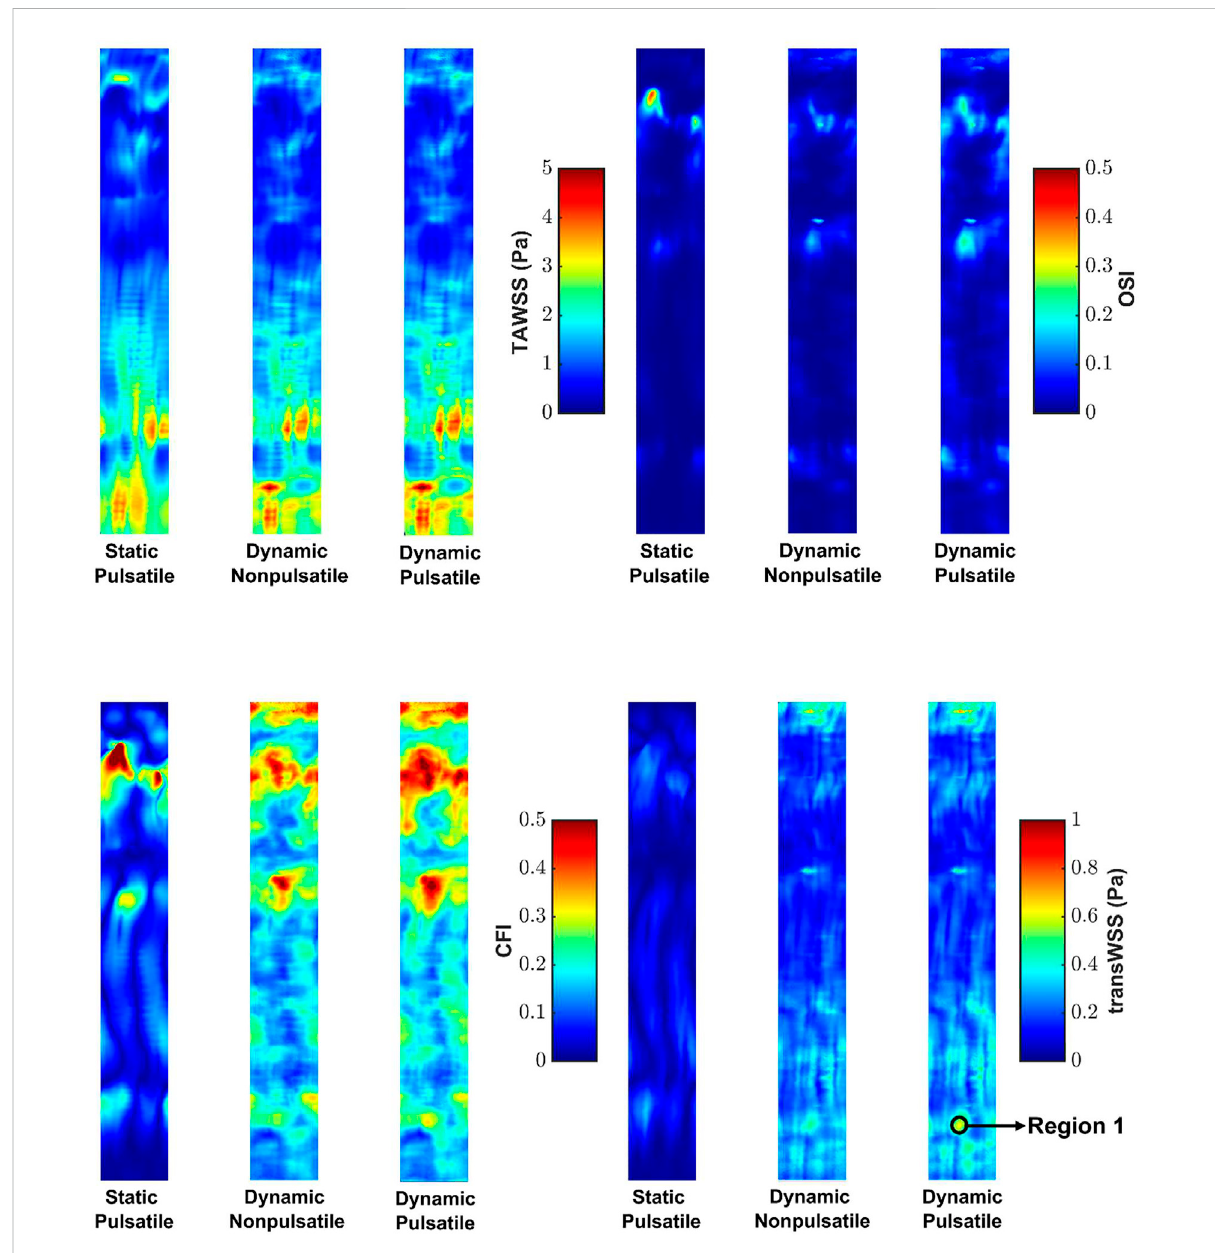
FIGURE 4 Maps of TAWSS, OSI, CFI and transWSS for the three cases. Mean RCA fl ow is from top to bottom.